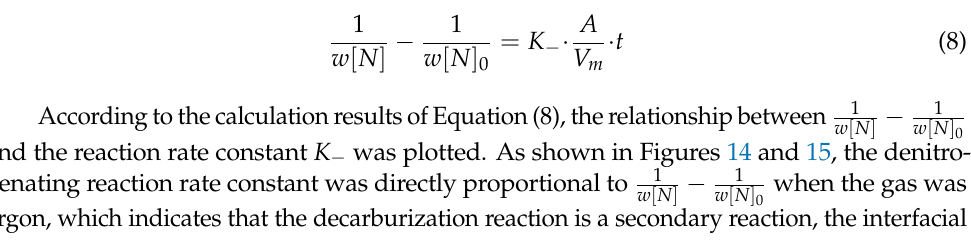
According to the calculation results of Equation (8), the relationship between 1 and the reaction rate constant K − was plotted. As shown in Figures 14 and 15, the denitro- genating reaction rate constant was directly proportional to 1 argon, which indicates that the decarburization reaction is a secondary reaction, the